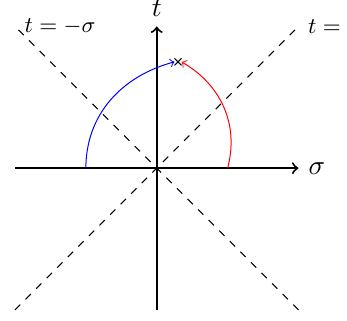
Figure 3 . The location of the branch cuts (dashed lines) in the conformal block in the σ - t plane. There is a branch cut in the holomorphic block at t = σ and in the anti-holomorphic block at t = − σ . When continuing the correlator from the t = 0 Euclidean slice into the future timelike region, one or the other of these branch cuts must be crossed leading to two candidate channels. These correspond to the continuations along the red or blue arrows. Note that along the Euclidean section the two branch cuts coincide, ensuring that in the spacelike region the holomorphic and anti-holomorphic blocks are on opposite